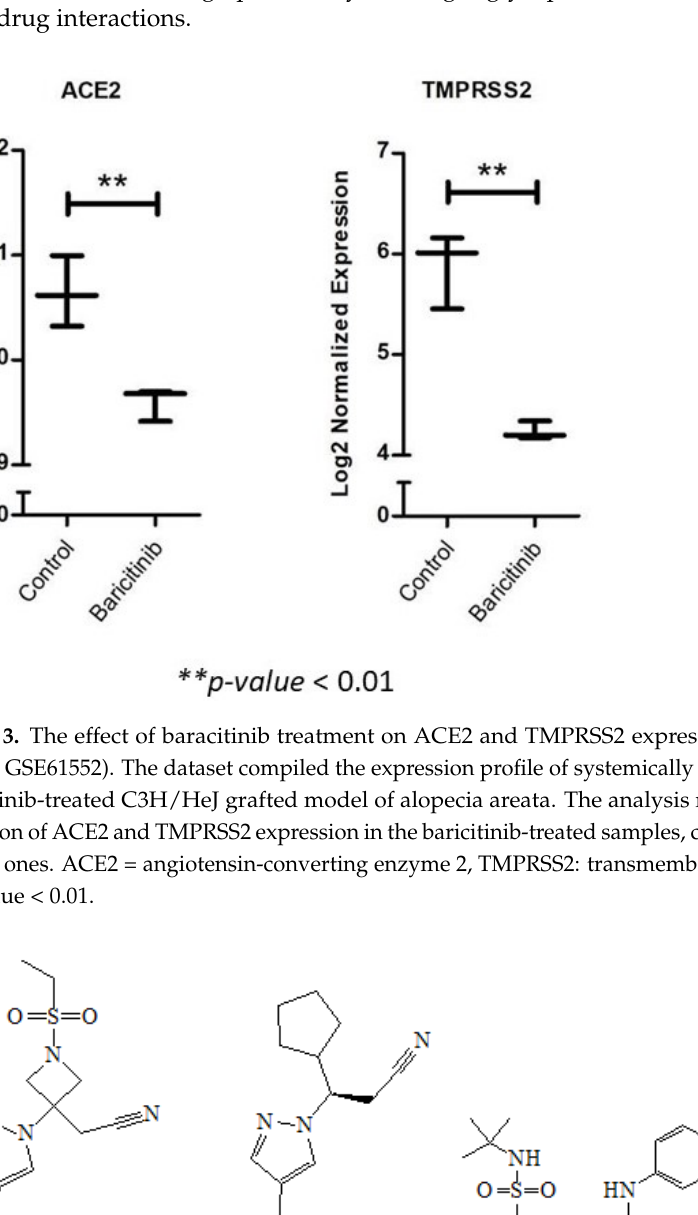
Figure 2. Dual mechanism of action of baracitinib; ( A ) to inhibit clathrin-mediated endocytosis of the SARS-CoV2, and ( B ) to inhibit the JAK-mediate release of pro-inflammatory cytokines. Our transcriptomic analysis of baricitinib-treated model revealed a significant down- regulation of ACE2 and TMPRSS2 in patients treated with baricitinib (Figure 3).